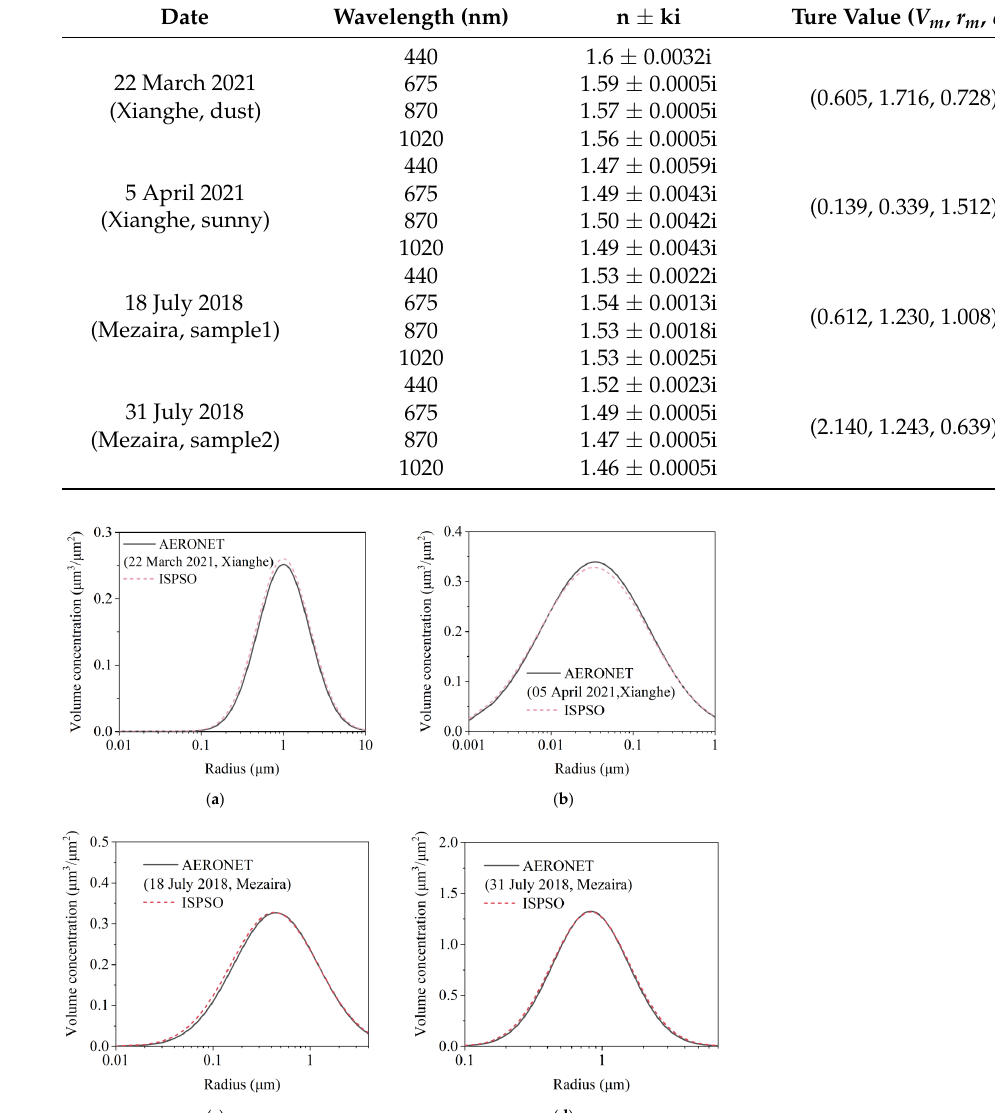
Table 9. The complex refractive index and PSD measured by AERONET.